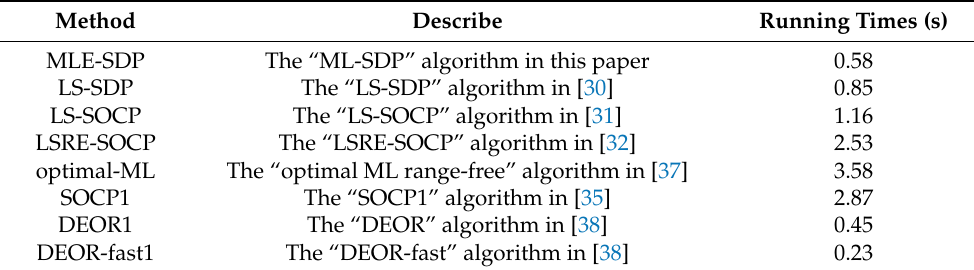
Table 4. Average running times of L 0 known